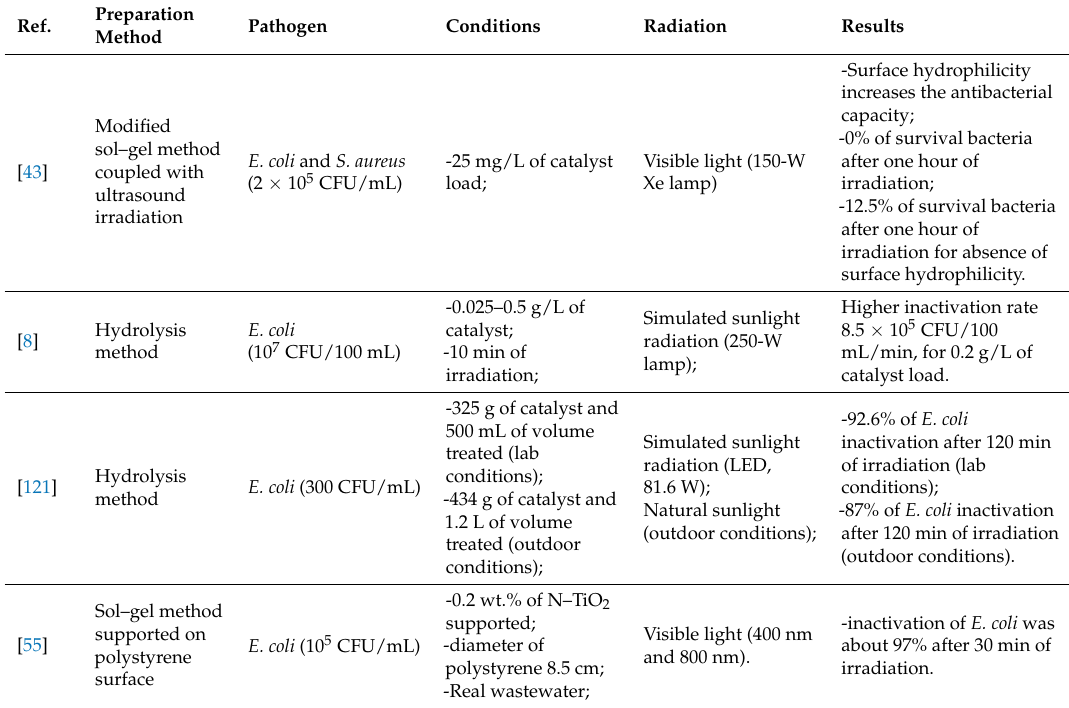
Table 4. Disinfection through photocatalytic